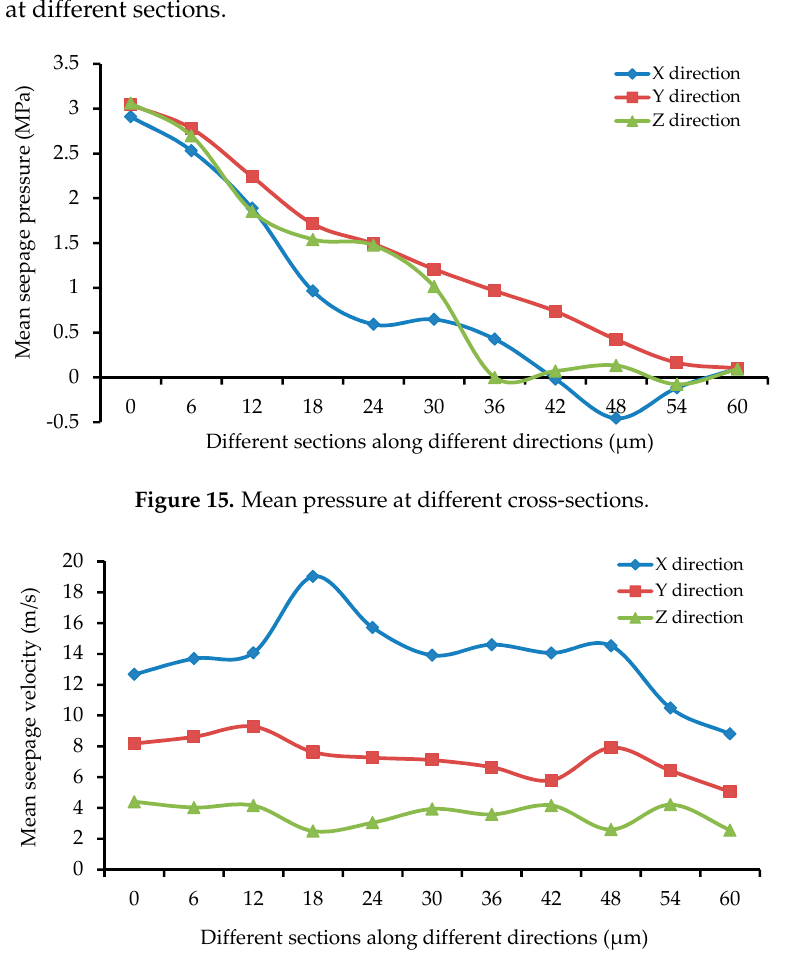
Figure 16. Mean seepage velocity at different cross-sections.